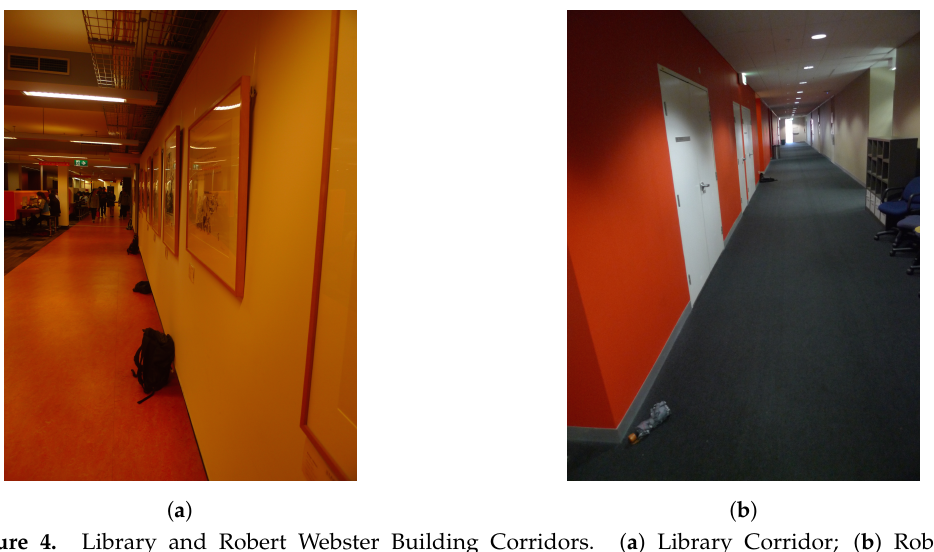
Figure 4. Library and Robert Webster Building Corridors. ( a ) Library Corridor; ( b ) Robert Webster Corridor.